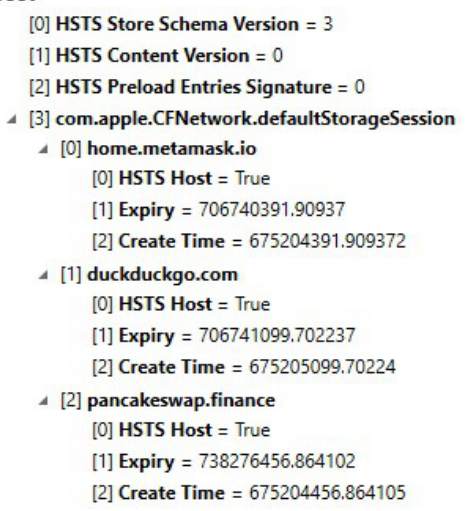
Figure 13. HSTS.plist file shows used services within the